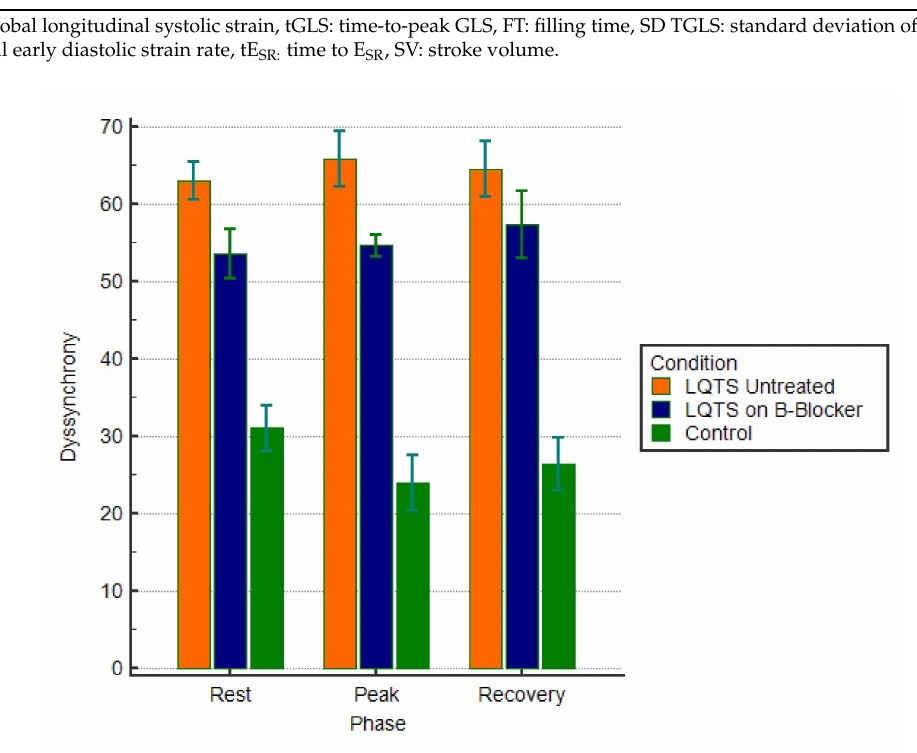
Figure 3. Dyssynchrony (SD-TGLS) response to exercise in LQTS mutation carriers treated